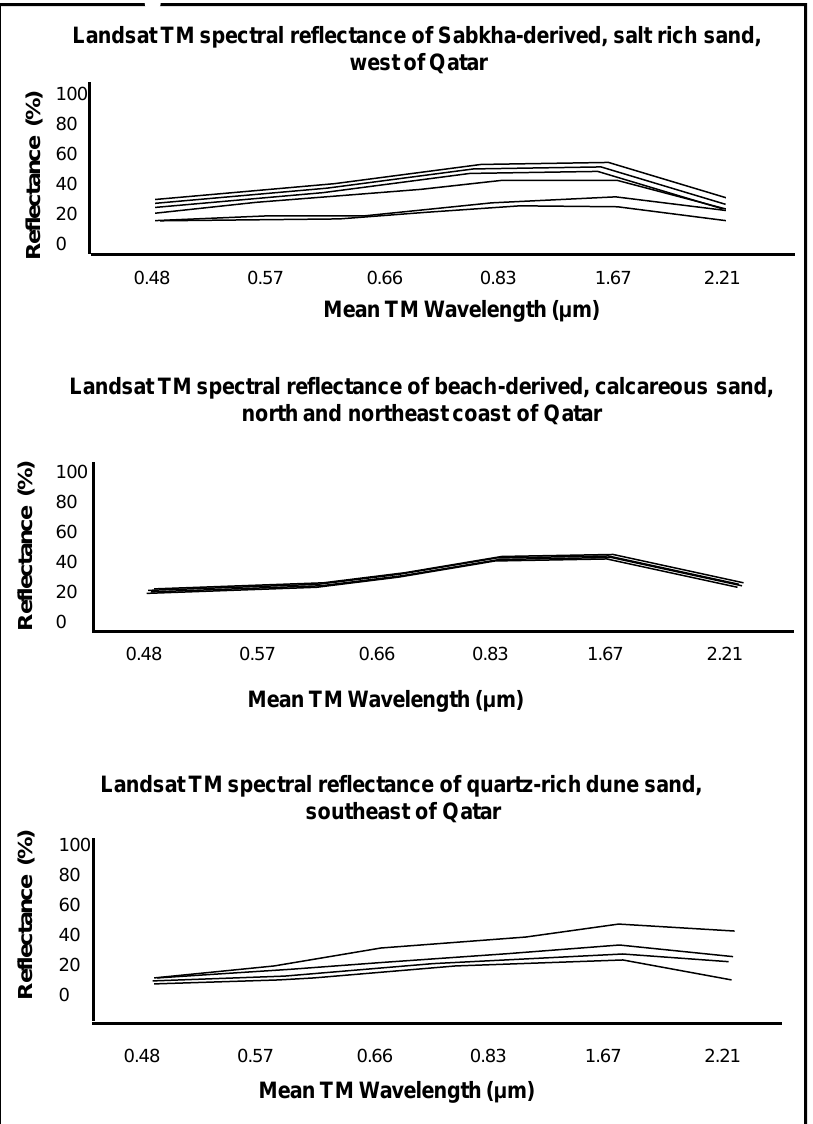
Figure 6. Example of Landsat TM spectral reflectance from the studied